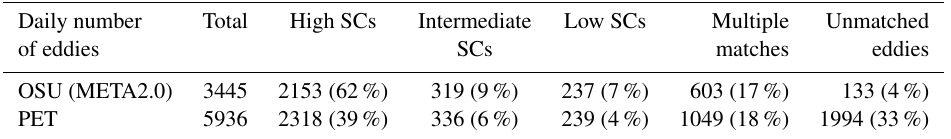
Table 2. Averaged daily number of eddies detected with the OSU or PET detection algorithms and the percentages relative to the total in parenthesis. The atlas generated with the PET detection mimics the META2.0 parameters. Note that the eddies are part of trajectories with a minimum lifetime of